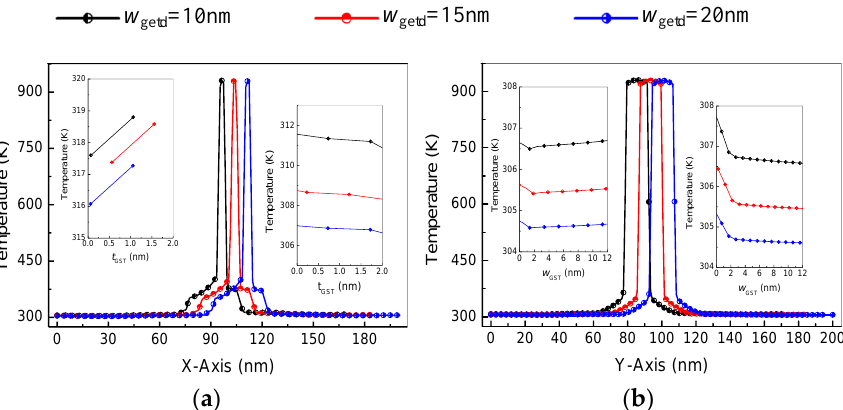
Figure 15. Temperature distributions on lines through the center point of the GST structure of the activated cell along axis with changing h GST values: ( a ) temperature distributions along x-axis; ( b ) temperature distributions along y-axis.